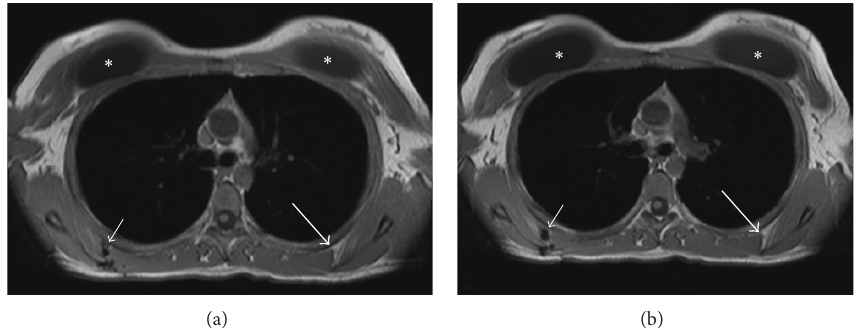
Figure 4: Magnetic resonance (MR) images of the patient’s scapulothoracic regions ((a) is more cranial than (b)). The left side of each image shows the area of the injury of the patient’s right scapulothoracic region (small arrows) and normal left side (larger arrows). The small arrows indicate recurrent bursitis and tearing of the serratus anterior and rhomboid attachments with disruption of suture material along the medial margin of the scapula. The asterisks indicate breast augmentation